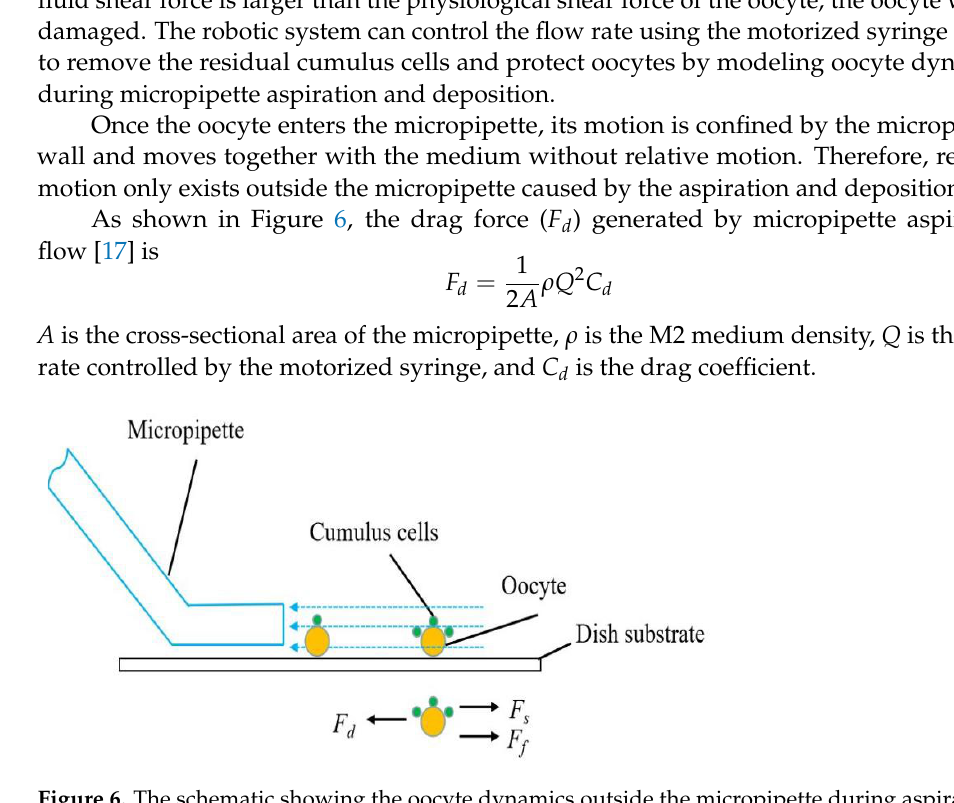
A is the cross-sectional area of the micropipette, ρ is the M2 medium density, Q is the flow rate controlled by the motorized syringe, and C d is the drag coefficient.